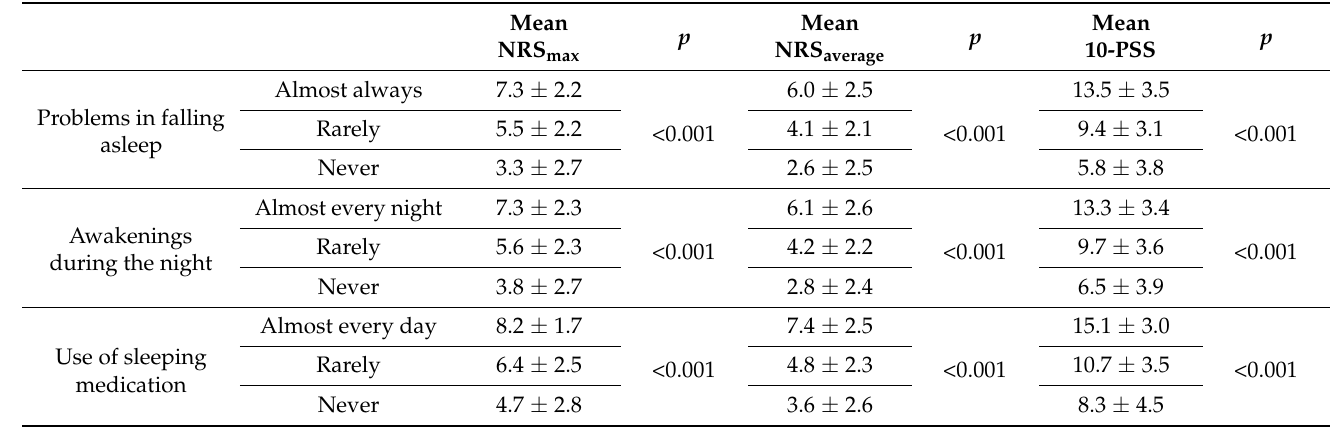
Table 4. Comparison of pruritus intensity in relation to the sleeping problems (10-PSS—10-item Pruritus Severity Scale, NRS average —average Numerical Rating Scale, NRS max —maximal Numerical Rating Scale).